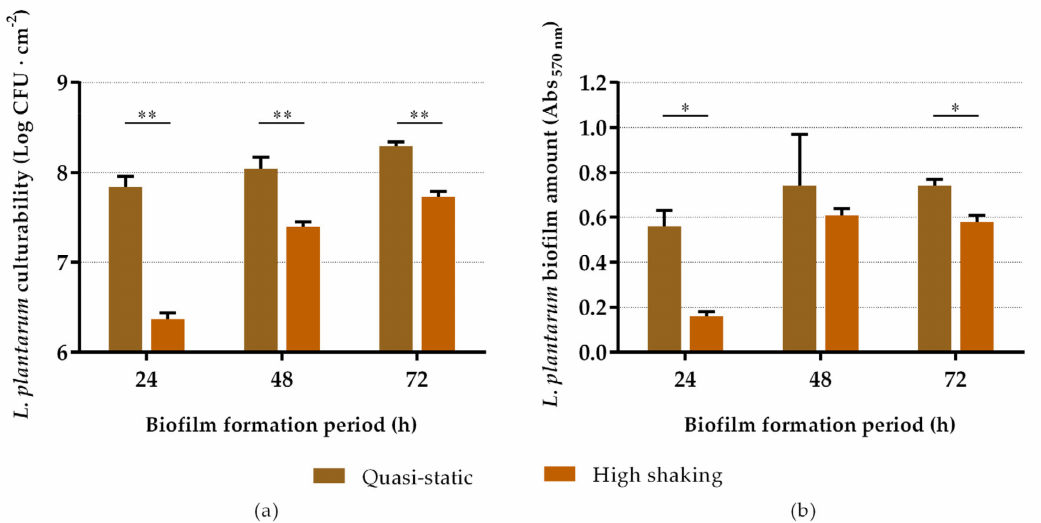
Figure 2. Culturability ( a ) and total biomass ( b ) of L. plantarum biofilms after 24, 48 and 72 h of development under quasi-static and high shaking conditions. Biofilms were formed on silicone coupons in MRS broth with medium replacement every day. The data present the mean and standard deviation (SD) of at least three independent experiments. Statistically significant differences between quasi-static and high shaking conditions were considered for p -values < 0.05 (* and ** indicate p < 0.05 and p < 0.01,